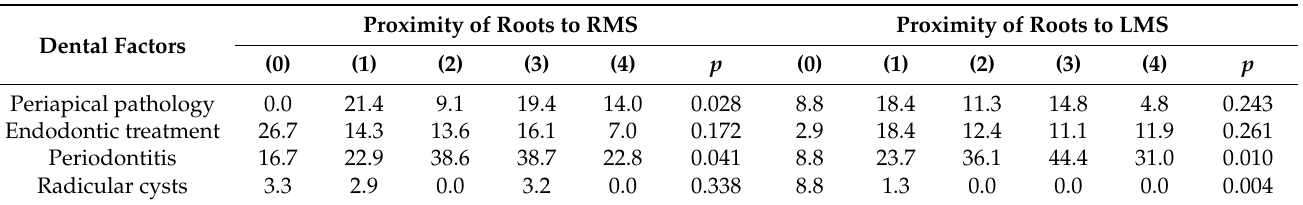
Table 4. Distribution, in percentages, of the different relationships between the dental roots and their statistical association with the dental factors.